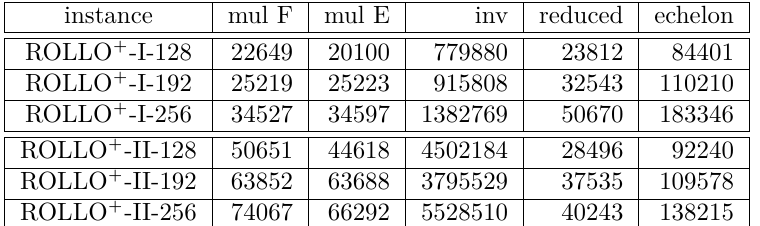
Table 3: Cycle counts for several components in our implementation for ROLLO `